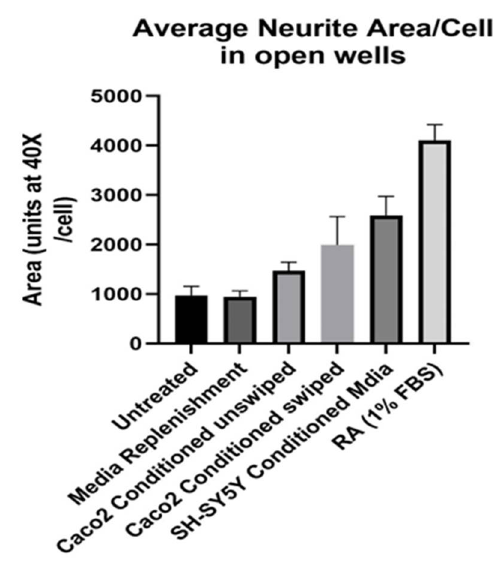
Figure 3. Conditioned media promotes longer SH-SY5Y neurites. SH-SY5Y’s were plated in open 24-well plates at low density ( n = 400/well) in complete (10% FBS) media. The experimental variable was type of media change on day 6. Namely, from left to right, the wells were either: untreated (no media change or addition); replenished with fresh complete media; replenished with complete conditioned media taken from confluent Caco2Bbe1 cells (not swiped); replenished with complete conditioned media taken from confluent Caco2Bbe1 cells swiped 2 days earlier; replenished with complete conditioned media from near- confluent SH-SY5Y cells (not swiped); or subject to switching to a media low (1%) in FBS containing 10 µM retinoic acid (RA). Two days afterward, media was removed, cells were washed and stained with crystal violet, and photographs were made using 40× phase contrast microscopy. Cells were traced and the average neurite area per cell was computed using ImageJ software. Bars are means ± SEMs. Significant p values by two-tailed, unpaired head-to-head t -tests were as follows: Media Replenishment alone vs. Caco2Bbe1 conditioned media unswiped ( p = 0.019). Media replenishment alone vs. Caco2Bbe1 conditioned media swiped ( p = 0.0004). Media replenishment alone vs. SH-SY5Y conditioned media ( p < 0.0001). Media Replenishment alone vs. RA in 1% FBS ( p < 0.0001). There were no significant differences between Caco2Bbe1 conditioned swiped vs. unswiped (0.091).